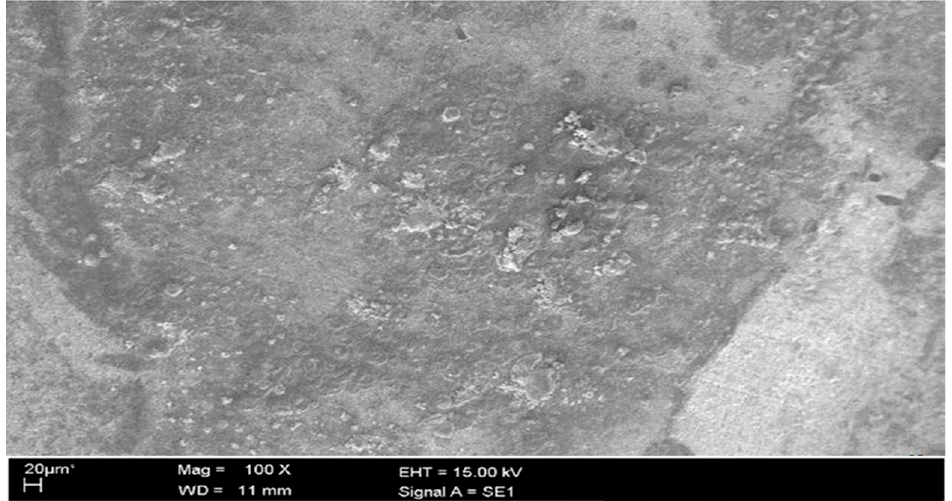
Figure 10. The SEM micrograph for mild steel in a corrosive solution in the absence of the corrosion inhibitor.